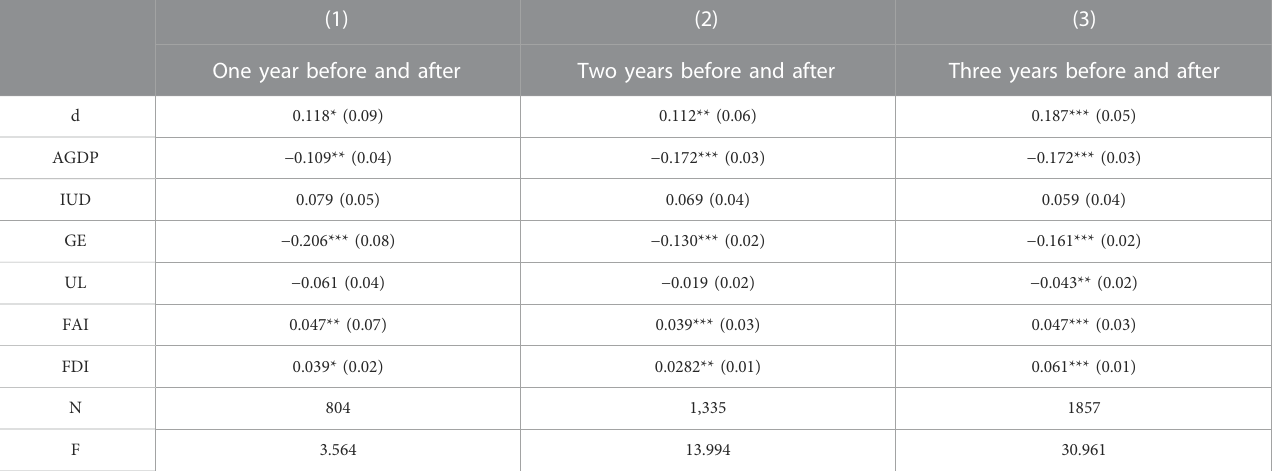
TABLE 6 Effect of different time window